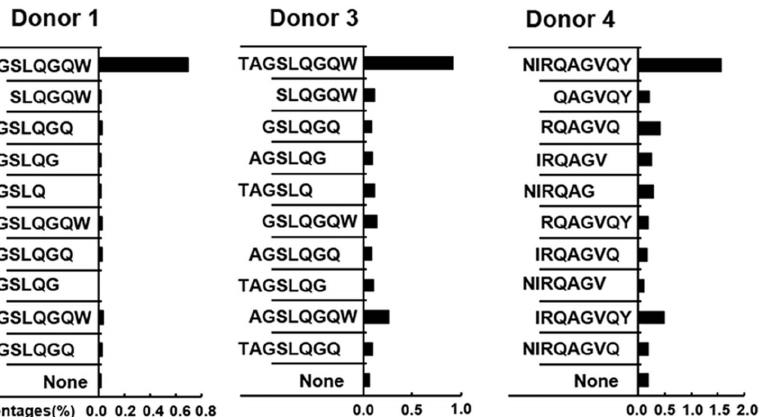
Figure 5. Minimal epitopes within CFP10 recognized by CD8 + T cells in PFCs from patients with TBP. A panel of truncated (6aa, 7aa or 8aa) peptides was synthesized to further map the minimal epitopes within CFP10 recognized by CD8 + T cells. PFCs from three CFP10-responsive patients were unstimulated or stimulated with truncated peptides. The expression of IFN- c by CD8 + T cells for the indicated conditions was analyzed and shown for each